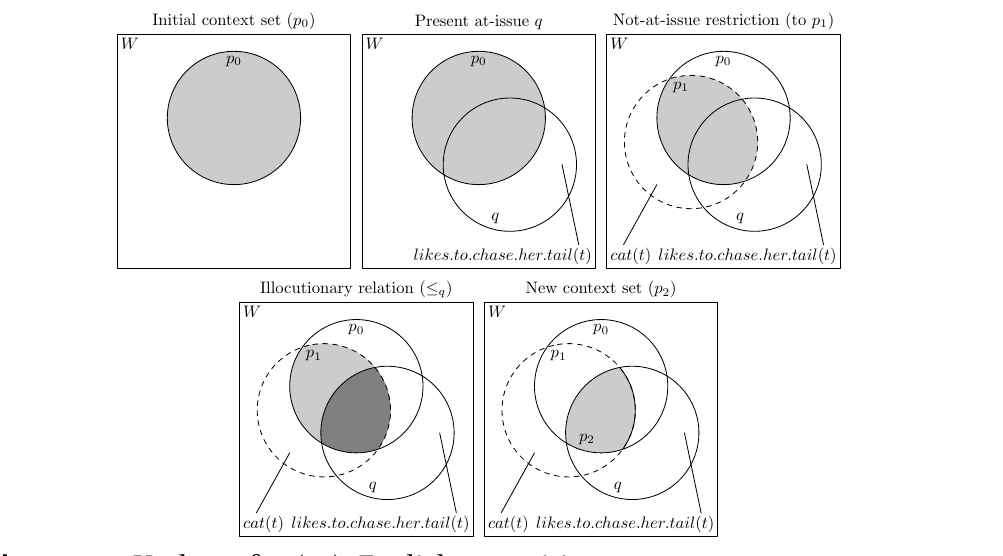
Updates for ( 23 ): English